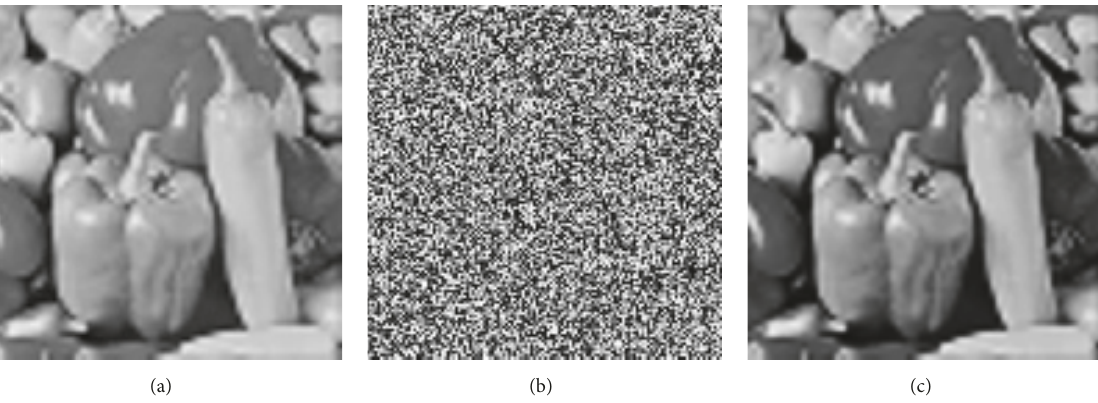
Figure 6: Original, encrypted, and decrypted images.